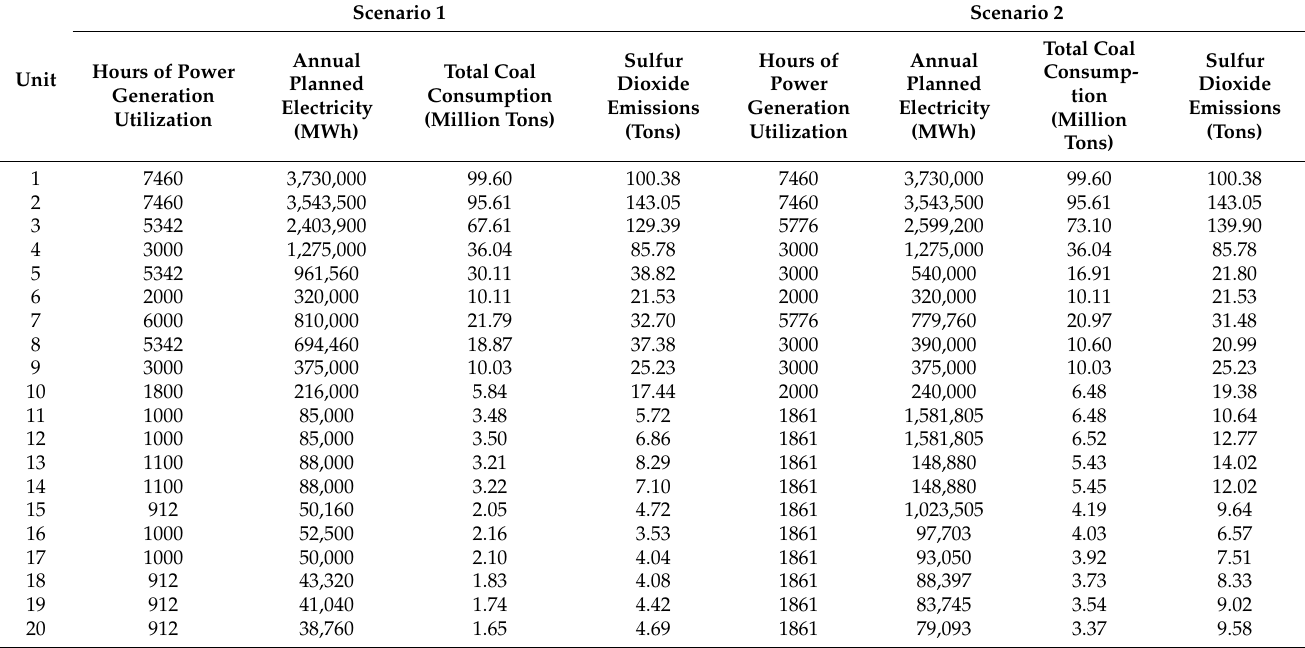
Table A2. Annual power plan results of each unit in two scenarios.